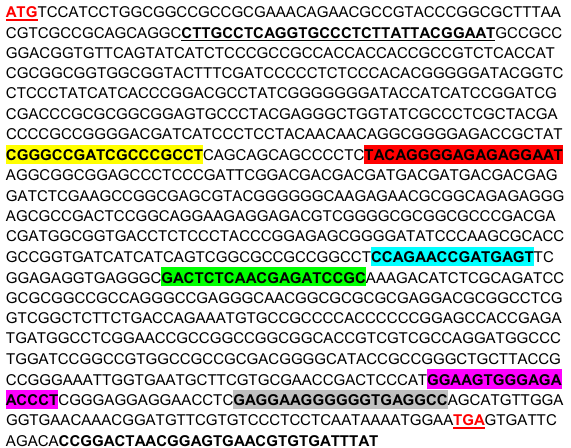
Figure 2. Targeting sites in the MCMV M80 and M80.5 overlapping region (M80 / 80.5, nucleotide no. 114434-115507). The targeting sites of TALEN plasmids MCMV 1, 2, 3, 4, 5 and 6 are highlighted in yellow, red, blue, green, purple and gray, respectively. ATG (start codon for M80.5) and TGA (stop codon for M80 and M80.5) are both in red and underlined. MCMV M80 / 80.5 forward and reverse primers are bolded and